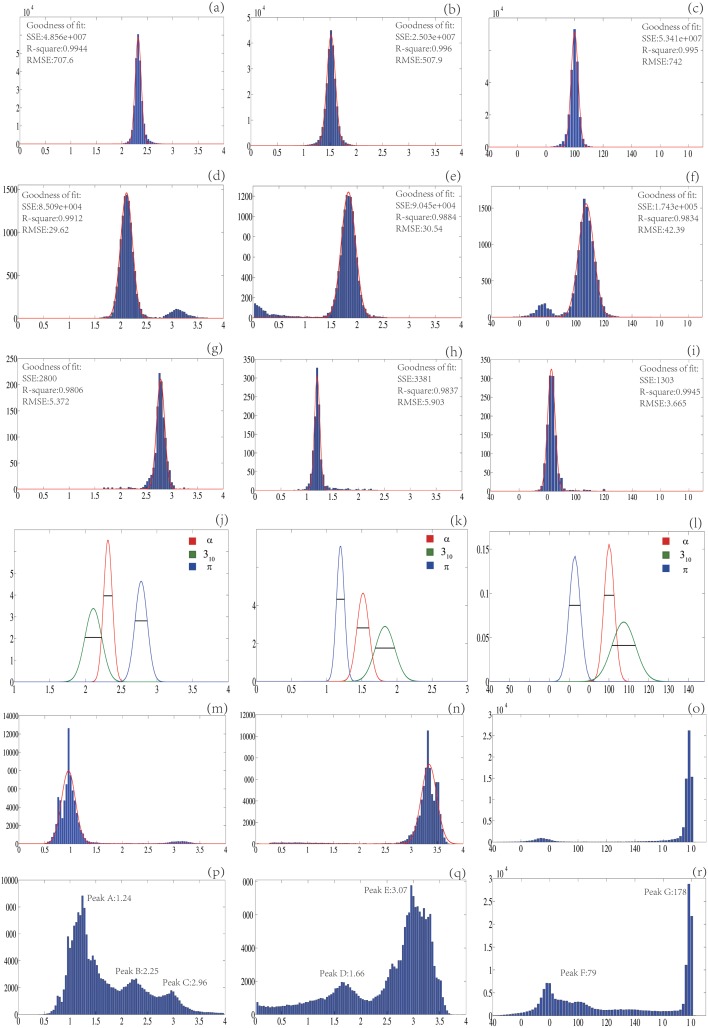
The r, p, t statistics for five different groups (H, G, I, E, R).The five triples of figures (a, b, c), (d, e, f), (g, h, i), (m, n, o) and (p, q, r) are respectively the r, p, t distributions for α-helix (H), π-helix(G), 310-helix (I), β-sheet (E) and the other (R) groups. Except for figures j, k and l whose y-axes are the scale for a normal distribution, the y-axes in all the other figures are the number of residues. For each row, the x-axis is respectively the radius (r in Å), pitch (p in Å) and turn angle (t in degree). There is a small peak in figures d, e, f from the left-handed helices. Figures j, k and l display the fitted r, p, t normal distribution curves for the three helix types where each line segment has a length of 2.0σ where σ is the standard deviation. All the overlaps are well below the 2σ lines except for t statistics where the overlap between the α-helix normal curve and 310-helix normal curve is slightly above the 2σ line.